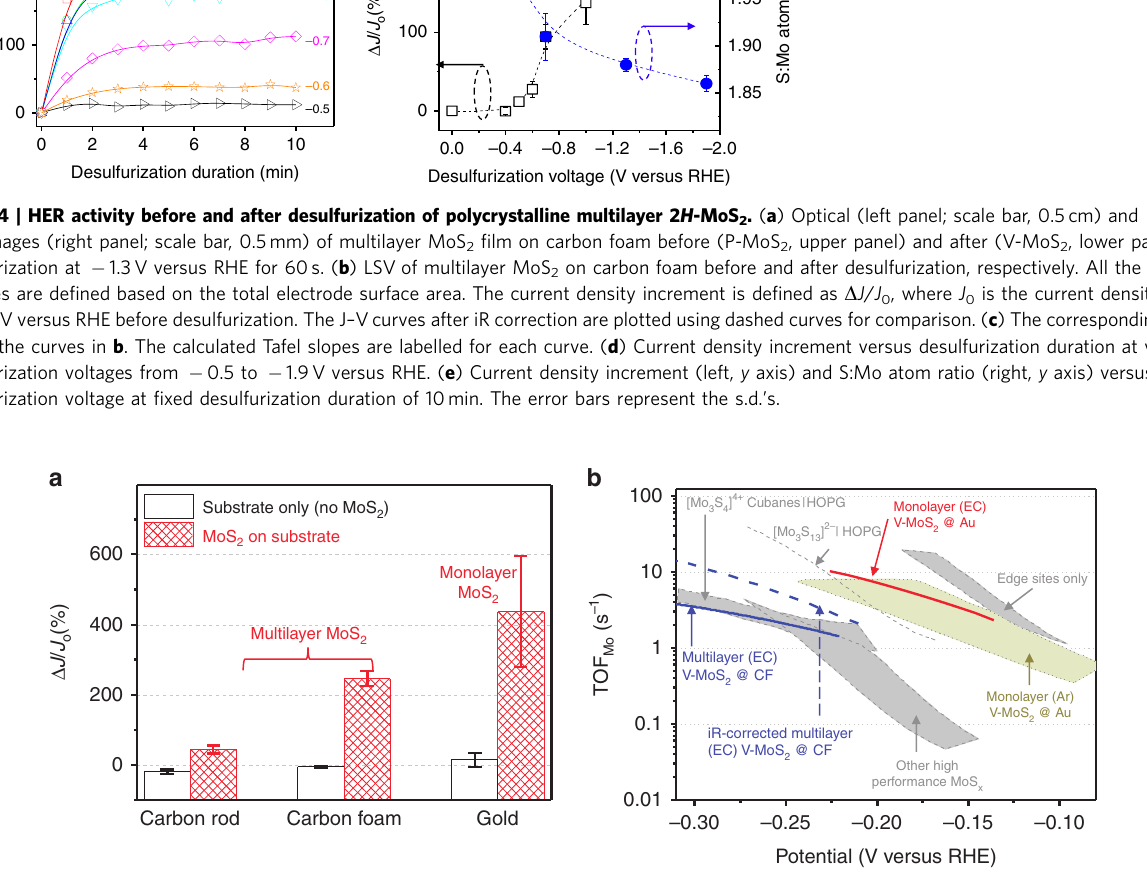
Figure 5 | Summary of the HER activity of electrochemically desulfurized MoS 2 . ( a ) Summary of the desulfurization effect on the enhancement of HER activity for multilayer MoS 2 on carbon rods and carbon foam substrates, and monolayer MoS 2 on Au substrates. The unfilled bars illustrate the effect of electrochemically desulfurization process on the substrates themselves and the effect is negligible. The error bars represent the s.d.’s among the samples. ( b ) Comparison of turnover frequencies TOF Mo per surface Mo atom between our samples and state-of-the-art MoS x electrocatalysts. Various state-of-the-art MoS x catalysts from ref. 24 are shown with non-bold labels. The light-green-coloured area is for Ar-desulfurized monolayer MoS 2 from ref. 9. The red solid curve is for electrochemically desulfurized monolayer MoS 2 on an Au substrate. The blue solid curve is for electrochemically desulfurized multilayer MoS 2 on carbon foam substrate without iR correction. The blue dashed curve is from electrochemically desulfurized multilayer MoS 2 on a carbon foam substrate with iR respectively. And the blue dashed curve represents the EC green-coloured area shows the TOF Mo range of Ar-desulfurized desulfurized multilayer MoS 2 on carbon foam with iR correction. monolayer MoS 2 (ref. 9). The red and blue solid curves represent the EC desulfurized monolayer MoS 2 on Au substrates and One can see that (1) the TOF Mo of our desulfurized monolayer multilayer MoS 2 on carbon foam substrates without iR correction, MoS 2 (red solid curve) is close to the highest TOF Mo ; and (2) the